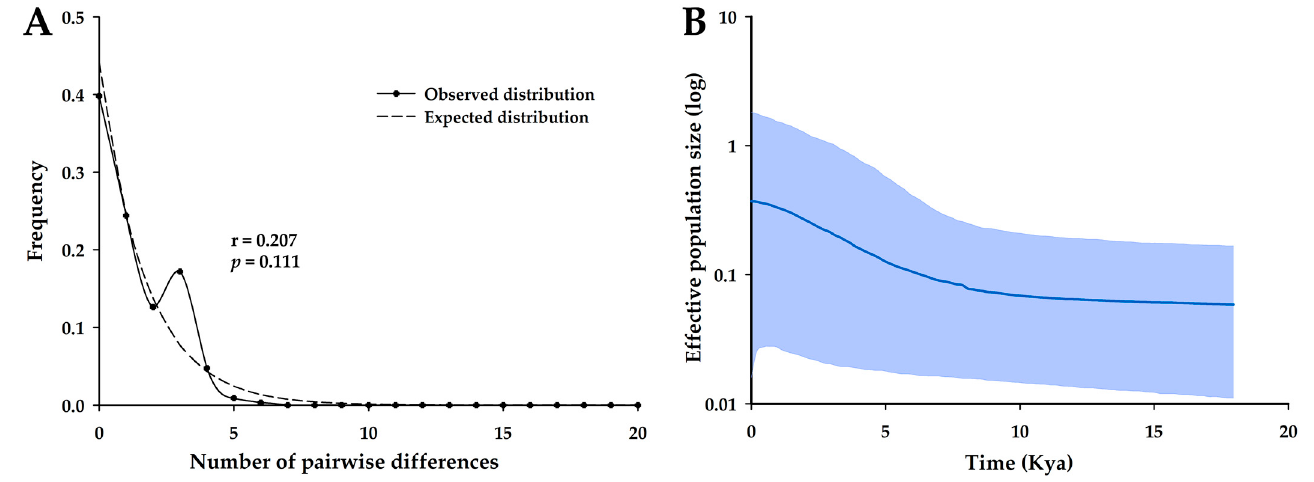
Figure 2. Mismatch distribution ( A ) and Bayesian skyline plot ( B ) of 67 Orientocoluber spinalis samples based on concatenated mtDNA ( Cytb + ND4 ; 1809 bp) across populations in South Korea. In panel ( A ), the solid line represents the observed distribution of pairwise differences and the dotted line represents the expected distribution, assuming population expansion in the mismatch distribution. A raggedness index value (r) is included. In panel ( B ), the solid dark blue line represents the mean value of the log10 effective population size, while the gray-blue area shows the 95% highest posterior density interval in the Bayesian skyline plot. Kya, thousand years